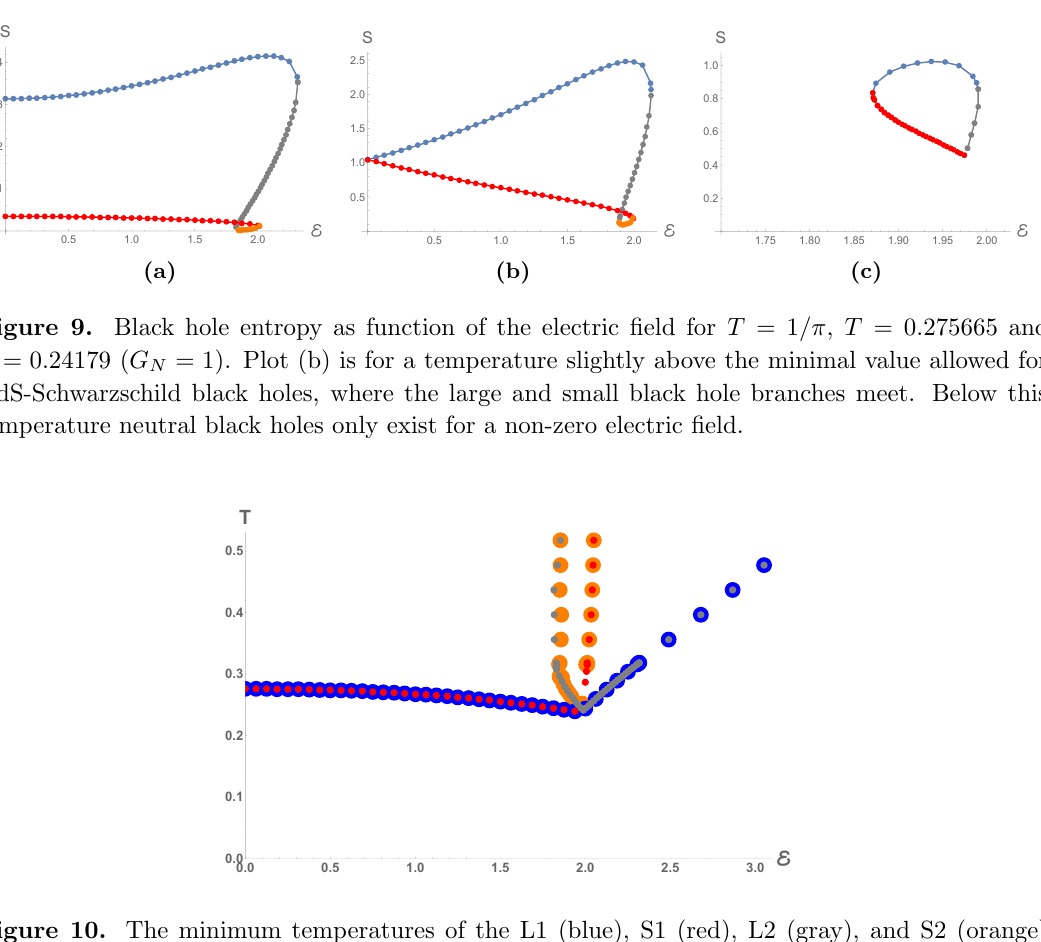
Figure 10. The minimum temperatures of the L1 (blue), S1 (red), L2 (gray), and S2 (orange) curves as a function of E